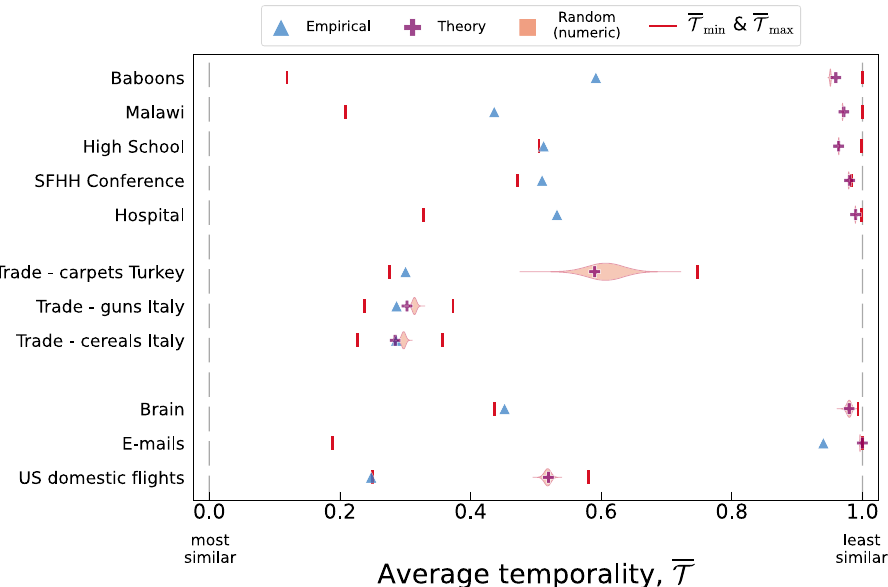
Figure 2. Characterization of the average temporality, T , of the empirical datasets considered in our study. For each dataset, we display the empirical value of T , its theoretical estimation, the distribution (violin plot) of the temporality of randomly shuffled sequences of snapshots, and its maximum and minimum possible values ( T max , T min ). The vertical dashed lines at T = 0.0 and T = 1.0 highlight the temporality’s theoretical boundaries. To compute the violin plots, we generate 5 × 10 6 randomly shuffled